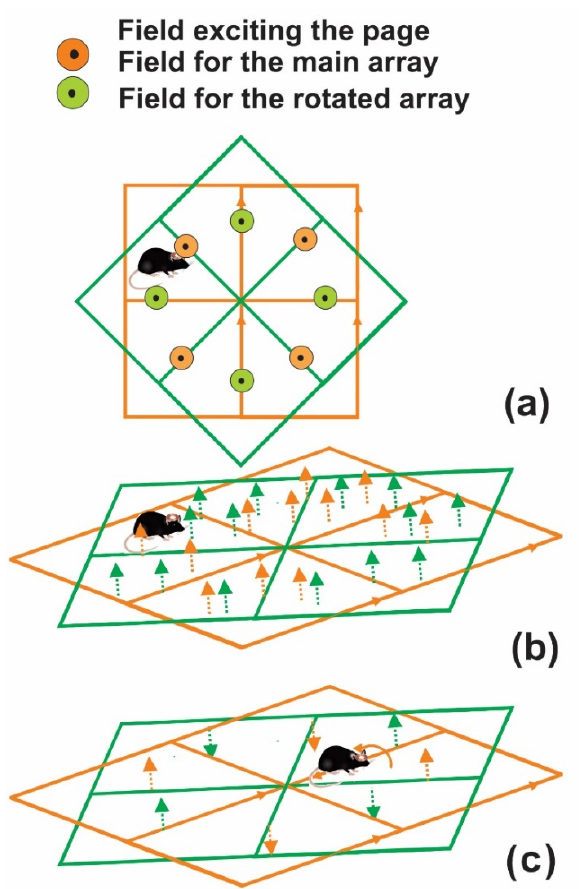
Figure 3. ( a ) Top view and ( b ) side view, in-phase excitation of the arrays. Current flows in opposite directions at the TX border area. ( c ) Out-of-phase excitation in the nearby coils in the vicinity and phase for the second TX array layer. The orange and green arrows show the TX array 1 and 2 EM field vectors respectively.